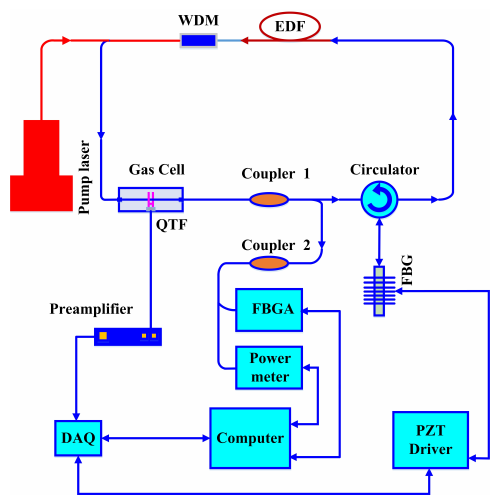
Figure 6. Schematic of the I-QEPAS sensor based on fiber-ring laser.